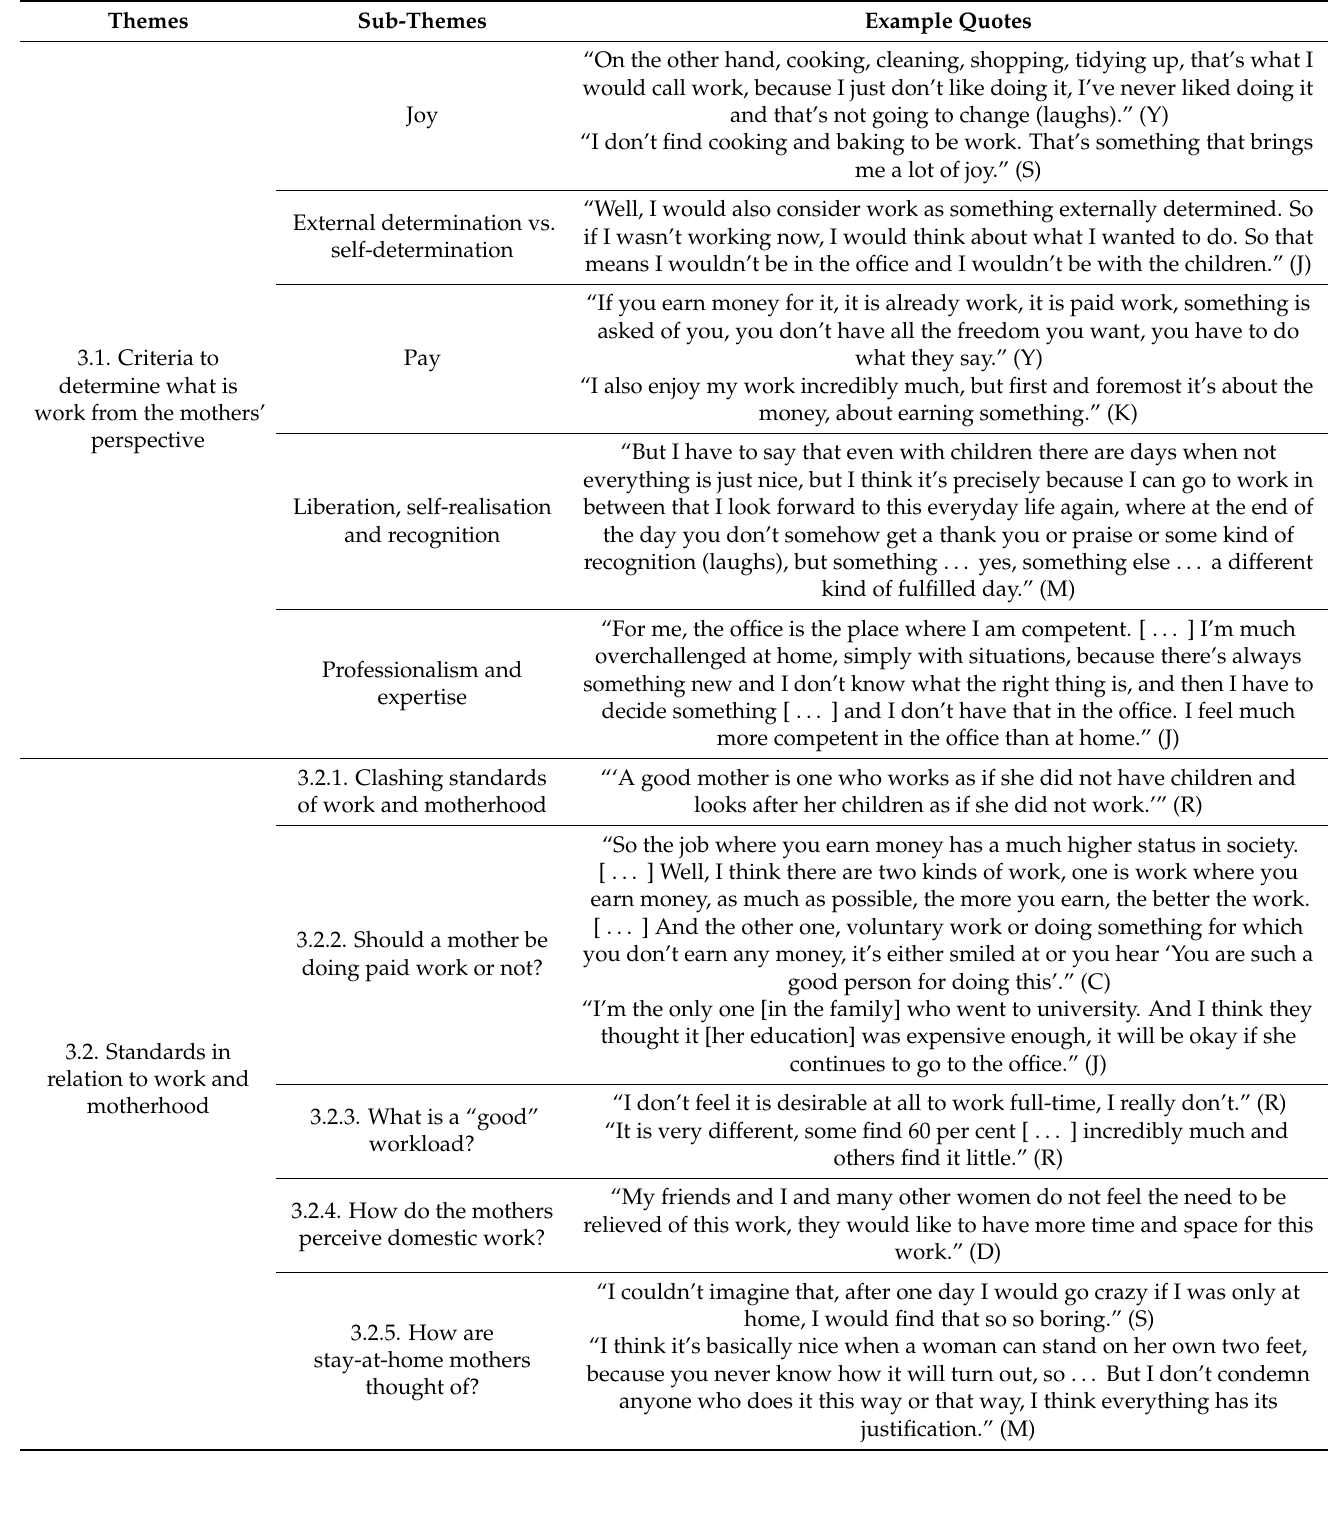
Table 2. The themes (umbrella concepts), the sub-themes (patterns of mothers’ experiences) found in the interviews, and the mothers’ quotes used to illustrate each